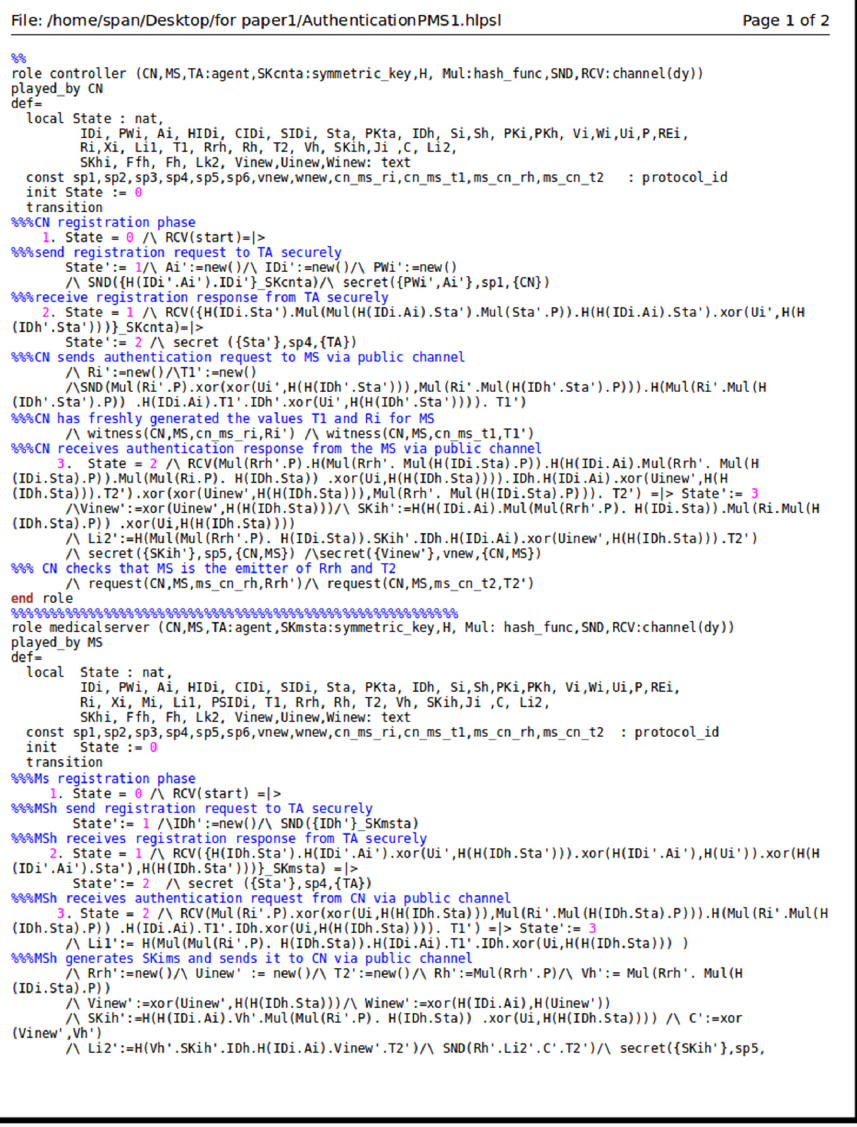
Figure 6. The HLPSL code of P-I.